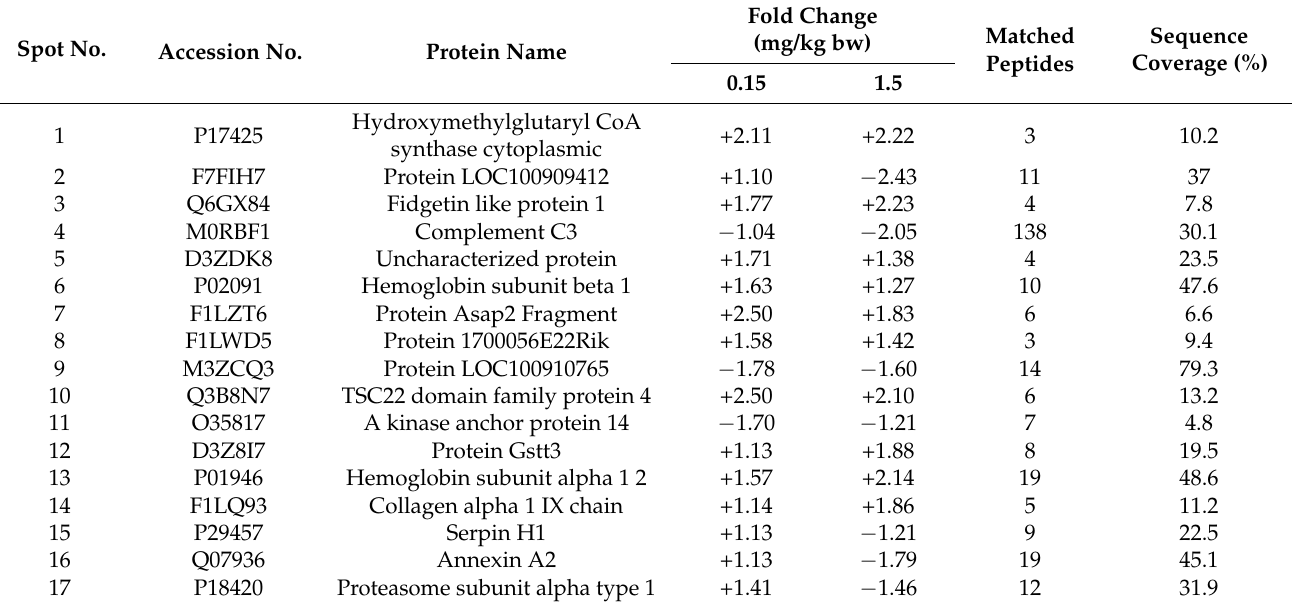
Table 1. UPLC-ESI-MSE identification of differentially expressed secreted proteins in the lungs of rats exposed to CuO